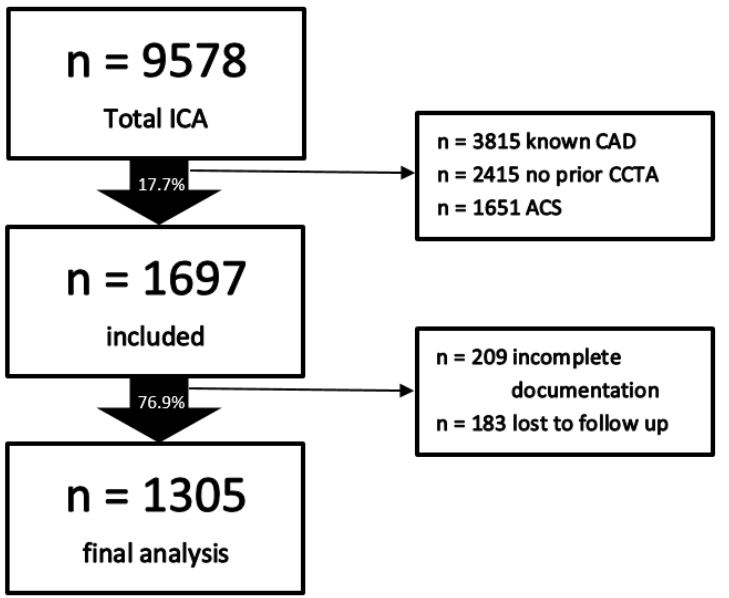
Figure 1. Study design. Abbreviations: ACS — acute coronary syndrome, CAD — coronary artery dis- ease, CCTA — coronary computed tomography angiography, ICA — invasive coronary angiography.